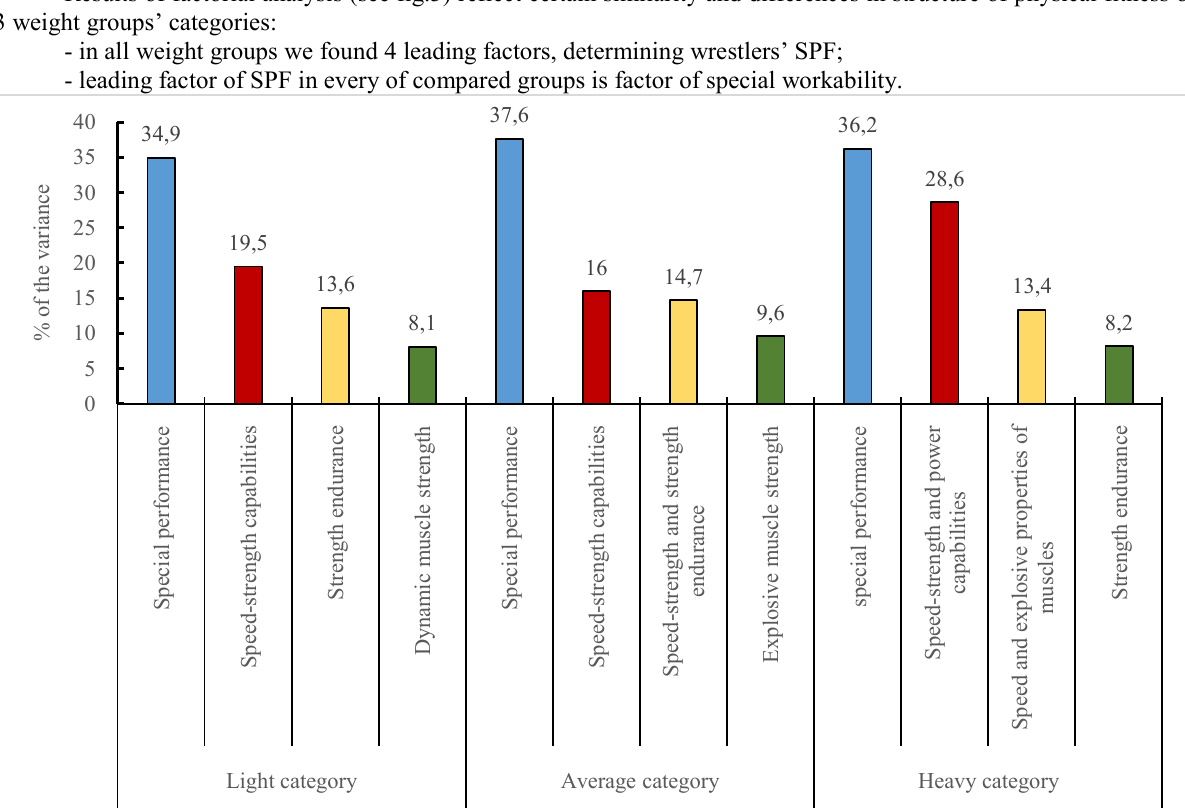
Fig.3. Factorial structure of physical fitness of 3 weight groups’